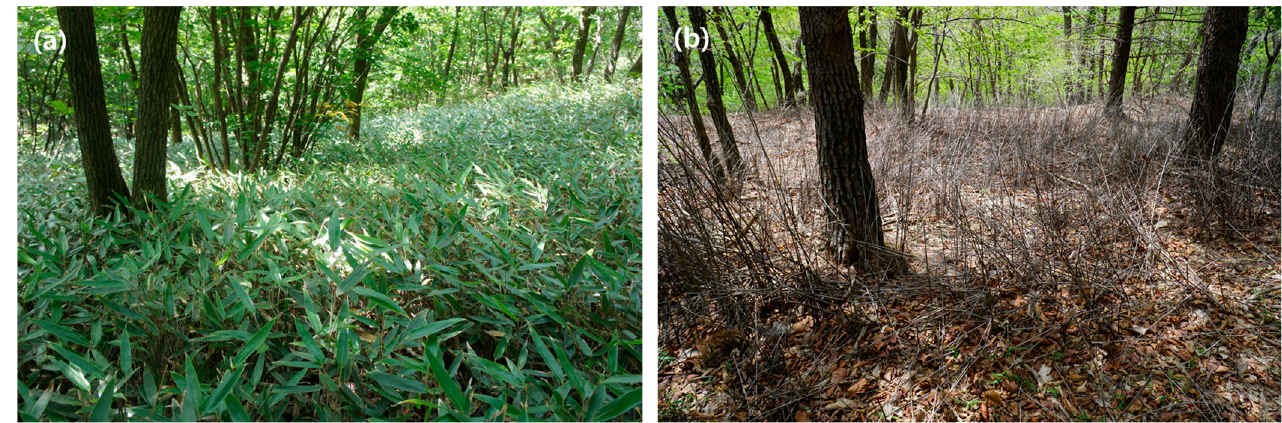
Figure 1. S. borealis population occupying the understory of closed forests. ( a ) Non-flowering S. borealis patch and ( b ) synchronous dieback of S. borealis following the synchronous flowering event in 2015.